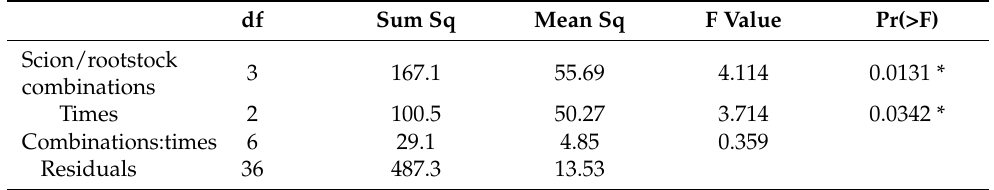
Table 1. Behavioral response of Aphis gossypii toward the different combinations, i.e., number of leaves with presence of aphids per plant; two-way ANOVA with interaction effect across the scion/rootstock